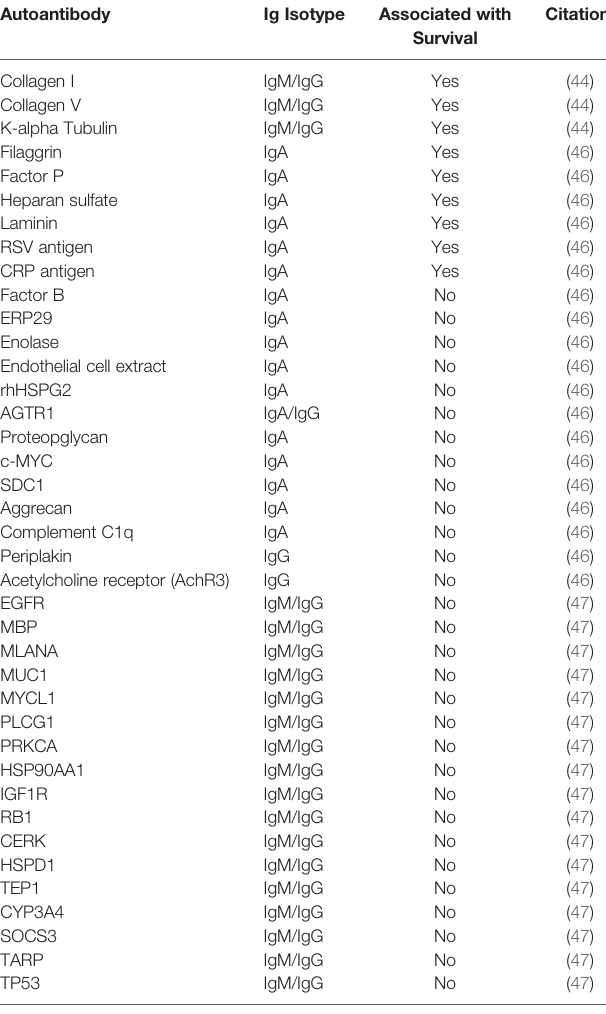
TABLE 2 | Pre-existing autoantibodies and primary graft dysfunction